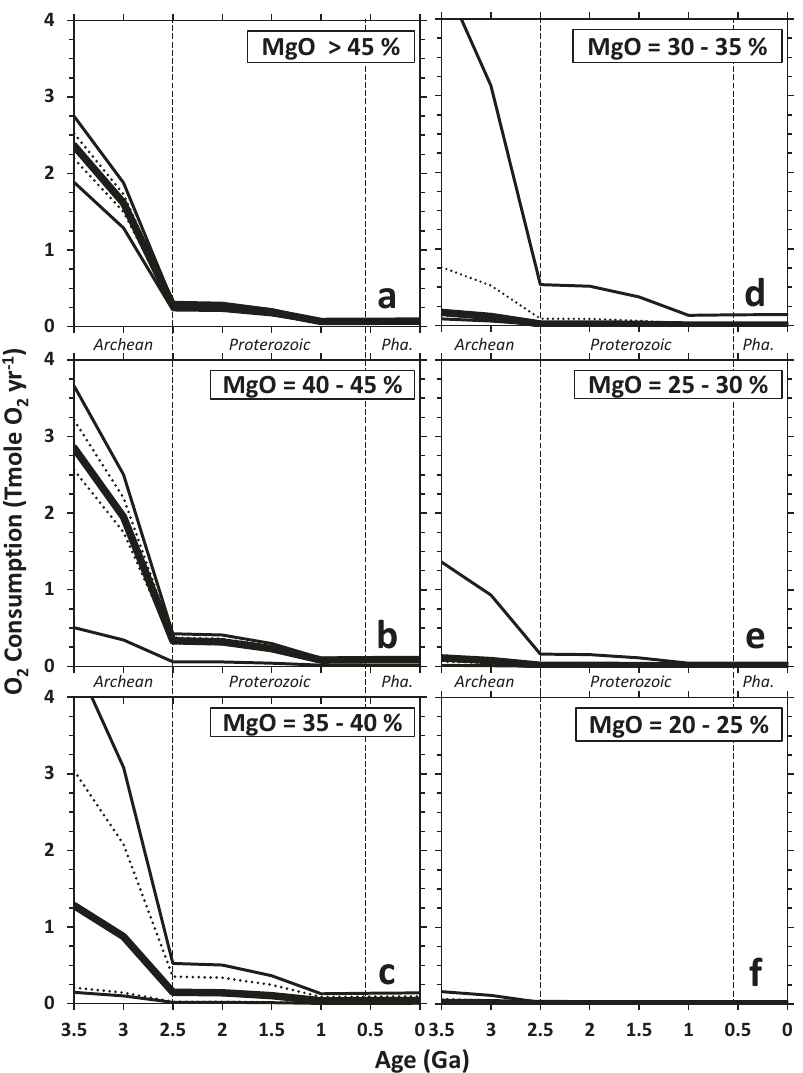
Fig. 3 O 2 consumption via continental serpentinization during the past 3.5 Ga. Global consumption rate for O 2 (Tmole yr -1 ) was calculated assuming an alteration rate of 10 -6 km yr -1 for rocks belonging to various compositional groups: a MgO >45, b 40 – 45, c 35 – 40, d 30 – 35, e 25 – 30, f 20 – 25 wt%. Extents of continental mass and exposure of komatiites are from Dhuime et al. 56 and Greber et al. 53 , respectively. Bold curve depicts median values. The lower and upper dotted curves represent 25th and 75th percentiles of model results, respectively, while the lower and upper thinner curves depict 5th and 95th percentiles of model results,